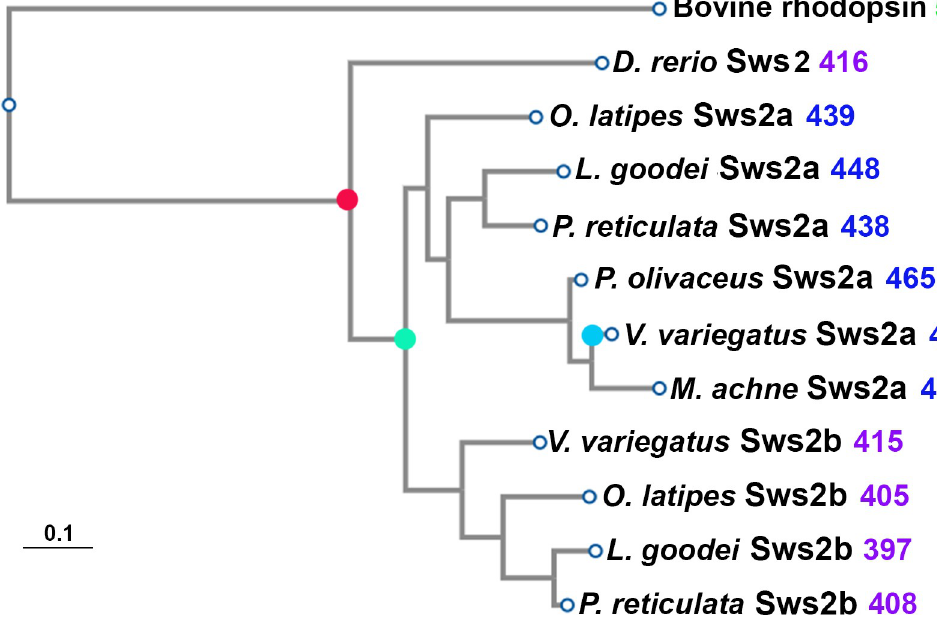
Fig 1. Evolutionary relationships of teleost Sws2 opsin proteins used in the simulations, as inferred by PhyML. Red filled circle indicates the speciation event that occurred prior to the duplication (green filled circle) of the sws2 opsin genes in teleosts [18]. The duplication generated the sws2a clade, which encode photopigments with λ max values that are shifted to longer wavelengths, and the sws2b clade, which encode photopigments with short-wavelength-shifted λ max values. The blue filled circle indicates the amino acid substitution A269T (with numbering standardized to the bovine rod opsin sequence) that is likely to be the spectral tuning site important for a further shift of the λ max value of V . variegatus Sws2a to longer wavelengths [23]. Experimentally measured λ max values (in nm) are indicated next to the name of each opsin and are color- coded for λ max values that are < 430 nm (violet) or > 430 nm